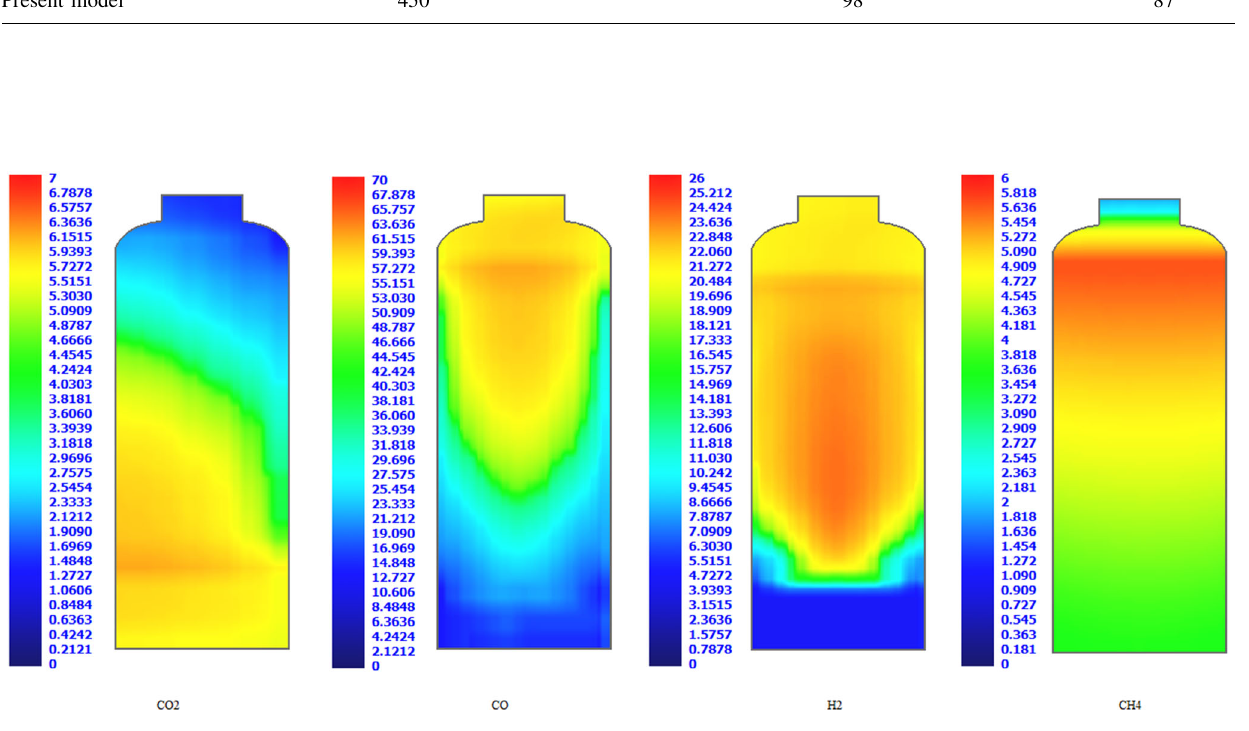
Fig. 6 Gas species contour distribution in the gasifier